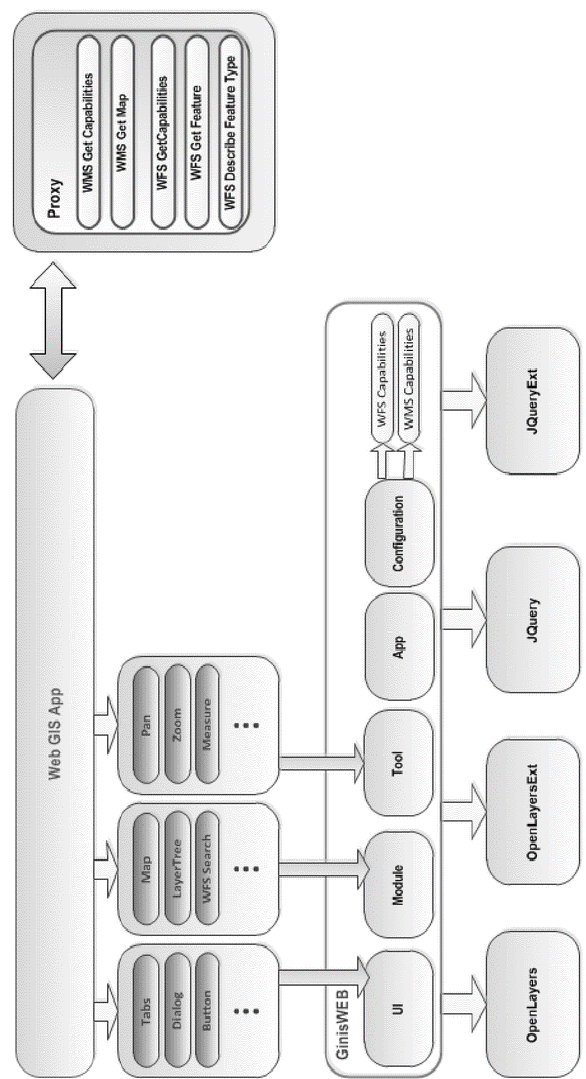
Figure 4. Flowchart of internal dataflow merged with sensor web and